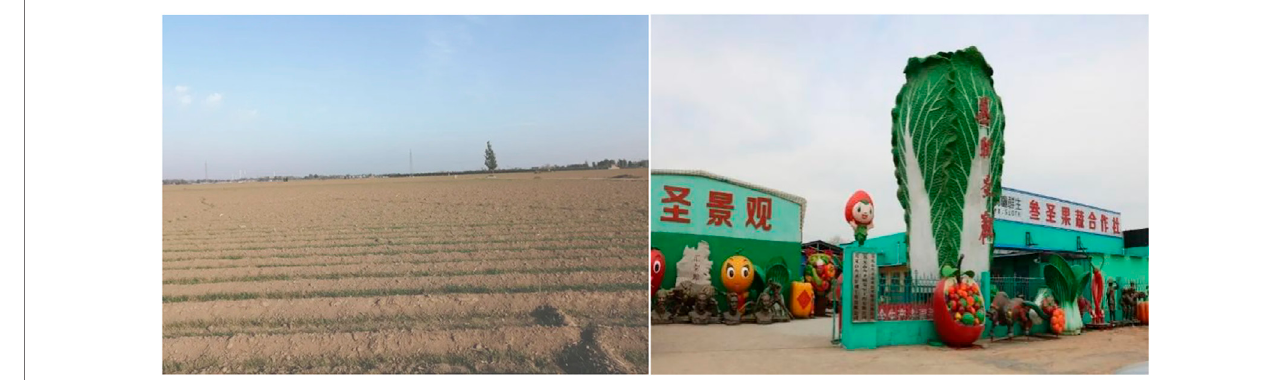
FIGURE 3 | Characteristic agricultural town.